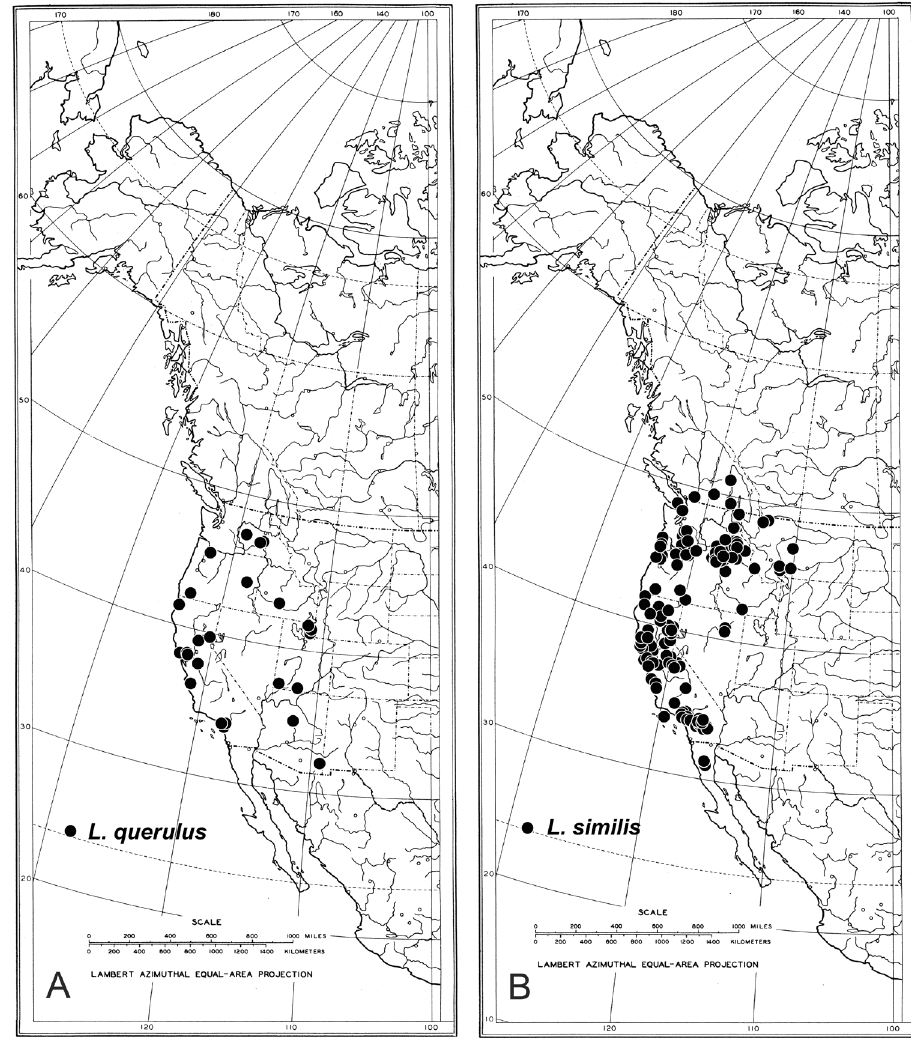
Figure 15. Known distributions of A Liancalus querulus Osten Sacken and B L. similis Aldrich. Legs: Coxae concolorous with pleura; remainder of legs dark metallic green-bronze, dusted with silver pollen; femoral ‘knees’ narrowly orange. Coxa I uniformly covered with white, slender hairs on anterior surface (length of hairs subequal to width of coxa I), with a few black, slender setae at apex. Coxa II with scattered white hairs anteriorly (those at apex longer and stouter), a couple black setae at apex, and a black ad seta just beyond 1/2. Coxa III with a black dorsal seta near 1/2. Femur II with row of short (≤ width of femur) posterior to pv setae on distal half, those near middle of femur white, longest and becoming black and shorter apically. Tarsus I(2) short (length subequal to width), slightly thickened, with ventral brush of setulae (Fig. 3E). Ratios of tibia:tarsomeres for leg I: 18-8-2-4-3-2; for leg II: 26-23-9-4-2-2; for leg III: